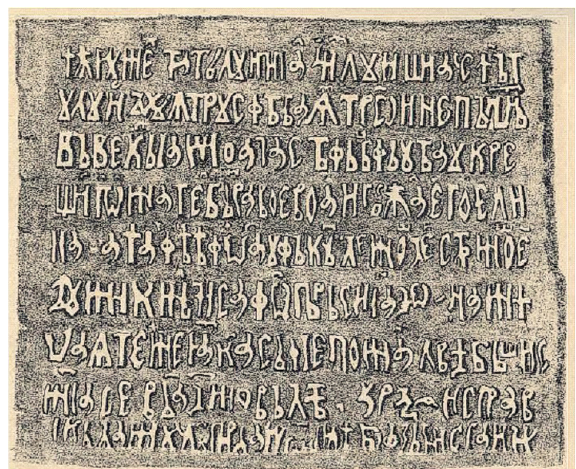
Fig. 10a. The original inscription of Popova Well at the reconstruction from 1651 (Pessiacov 1914).